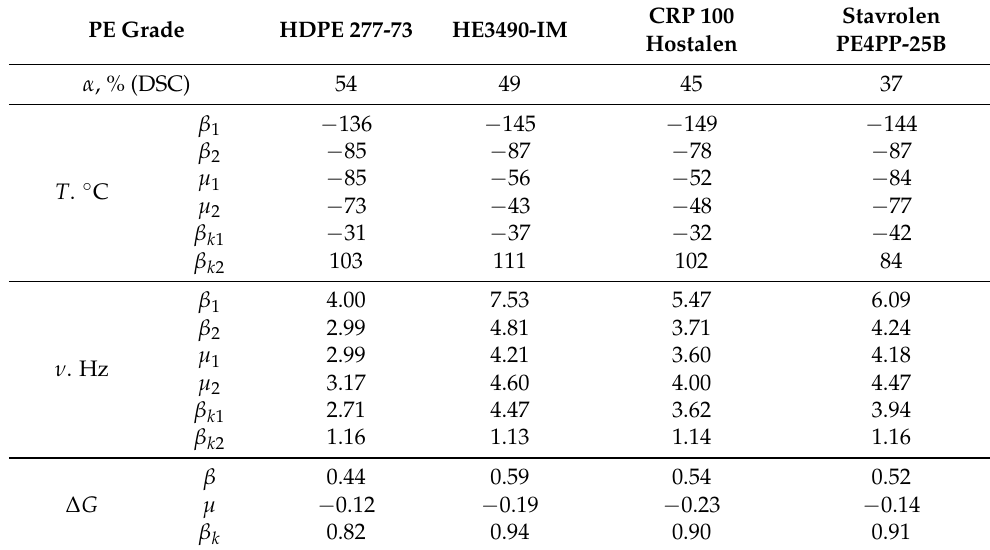
CRP 100 Stavrolen Hostalen PE4PP-25B